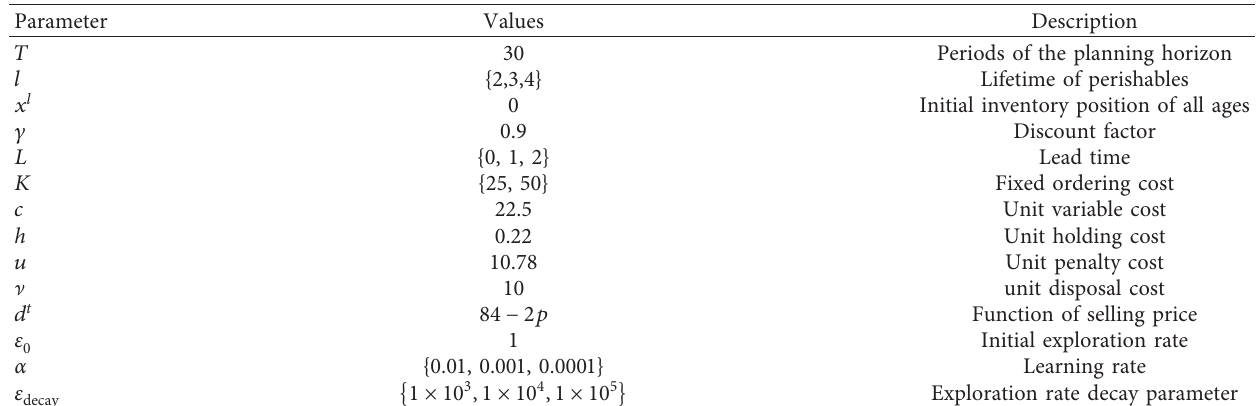
Table 2: The parameter